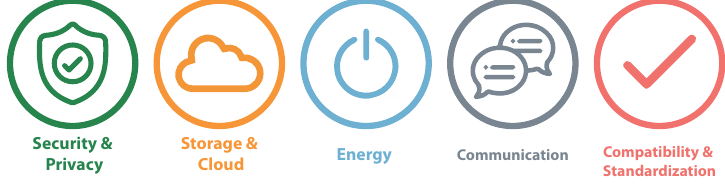
Figure 1. IoT technological